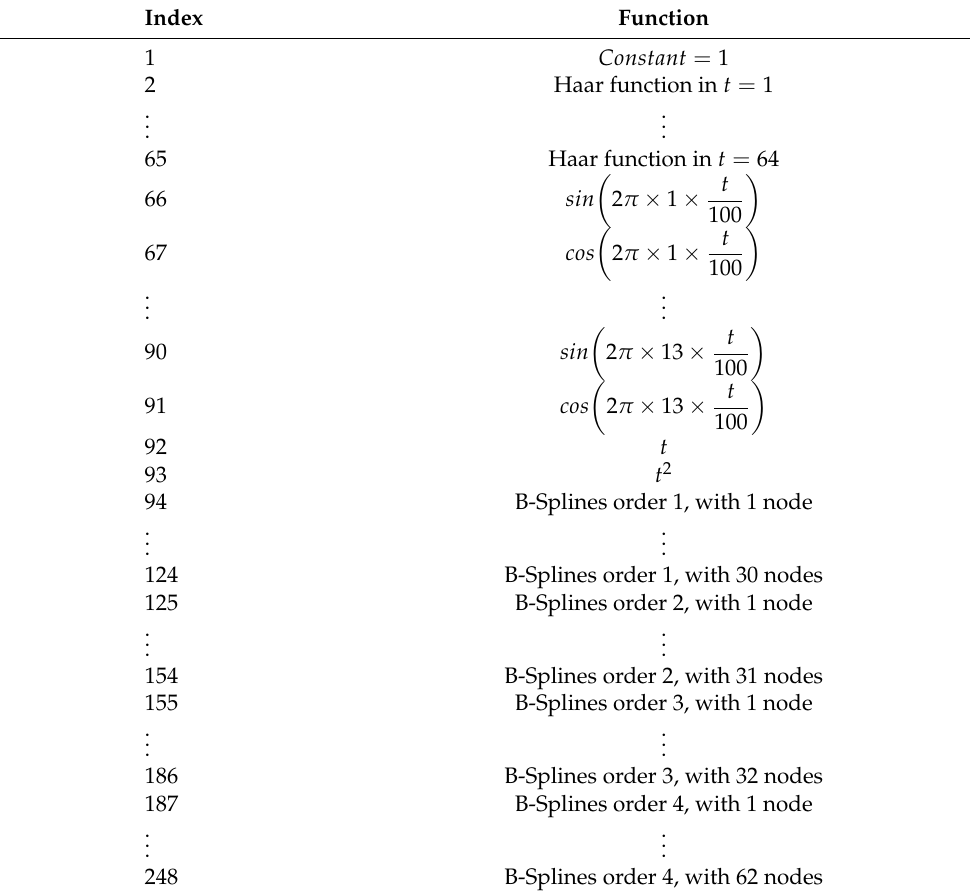
Figure 6. Dollar/Chilean peso series. The start dates of the social outburst and COVID-19 pandemic are indicated in vertical dashed lines. Table 1. Details of the 248-function dictionary applied to the dollar/Chilean peso